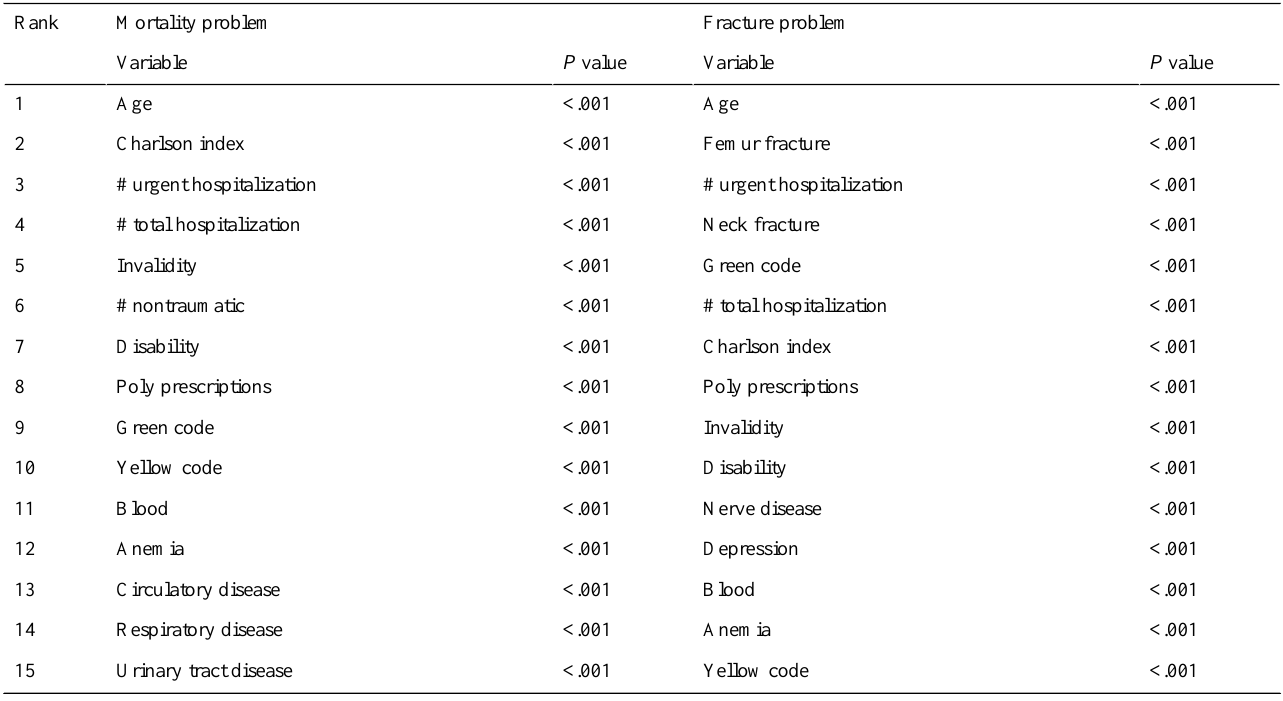
Table 2. The most important variables in the mortality and fracture